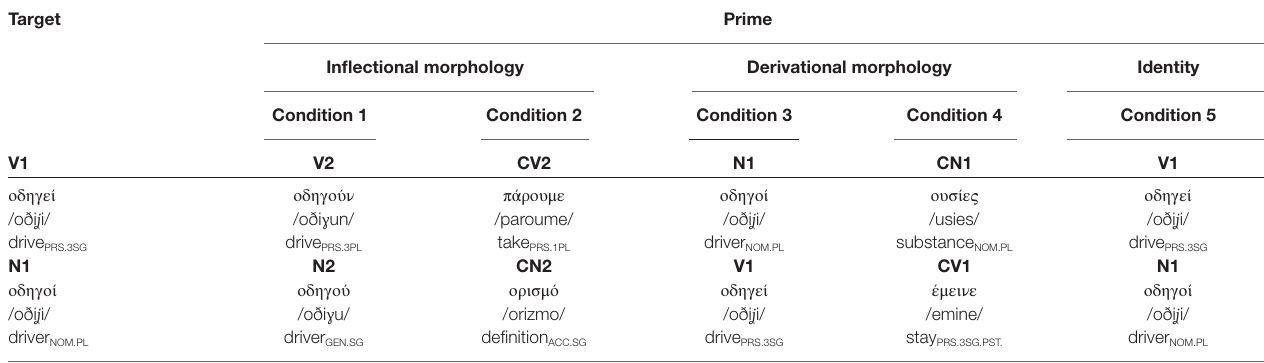
TABLE 4 | Summary of all experimental conditions of Experiments 1–4 with examples.